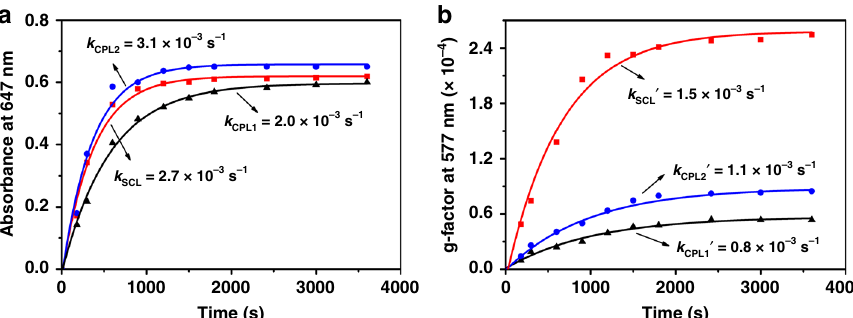
Fig. 3 Photo-polymerization kinetics. a Time-resolved development of absorption maximum at 647 nm for PDA chains upon irradiation with SCL (red lines), CPL1 (4.0 mW cm − 2 , black lines) and CPL2 (6.8 mW cm − 2 , blue lines). b Time-resolved development of g values maximum at 577 nm for helical PDA chains predominantly in one chiral state upon irradiation with SCL, CPL1, and CPL2. Solid curves in a and b are fi tted with single exponential function